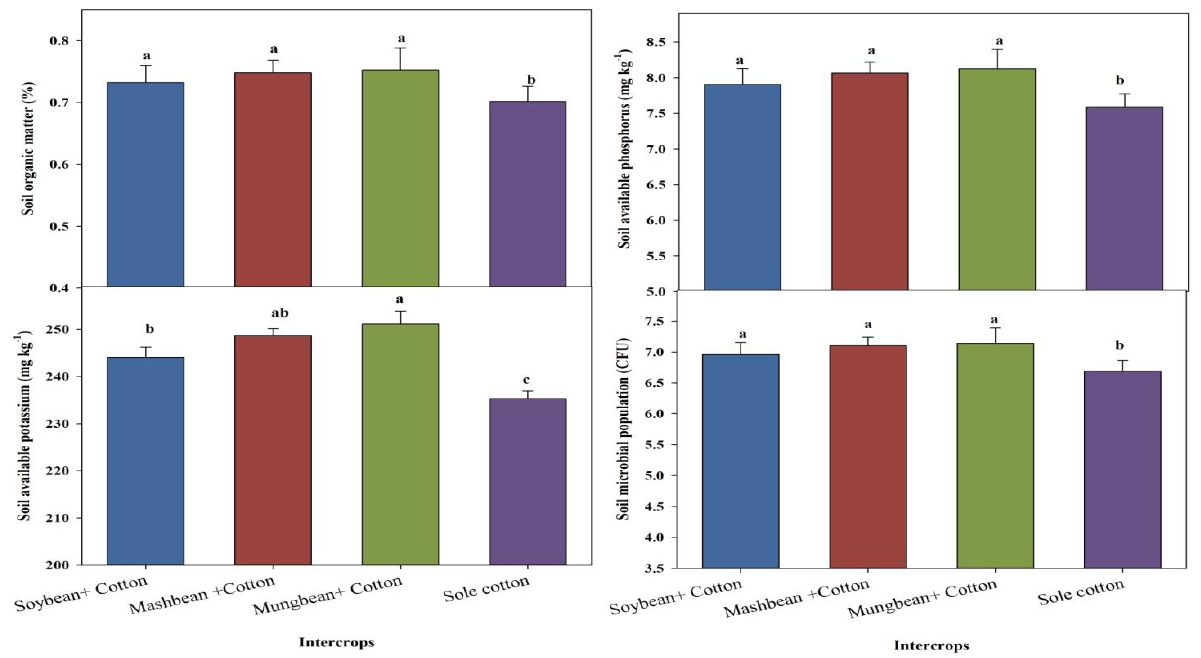
Figure 5. Effect of different legume intercrops on soil health indicators under arid climatic conditions. (Letters on graph bars “a, b, c, and ab” showed significant differences at p ≤ 0.05). (Tillage systems data are presented in Table 1, as some parameters were not significant, making them difficult to present in graph form).